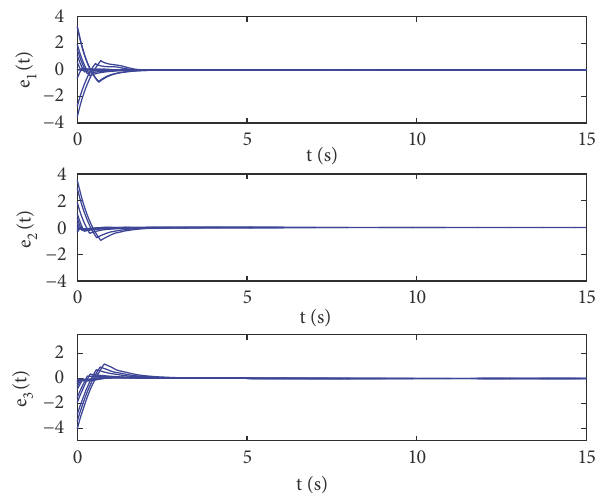
Figure 4: Select 10 random initial conditions and state trajectories of the synchronization errors 𝑒 1 (𝑡) , 𝑒 2 (𝑡) , and 𝑒 3 (𝑡) with 𝜉 =-1.